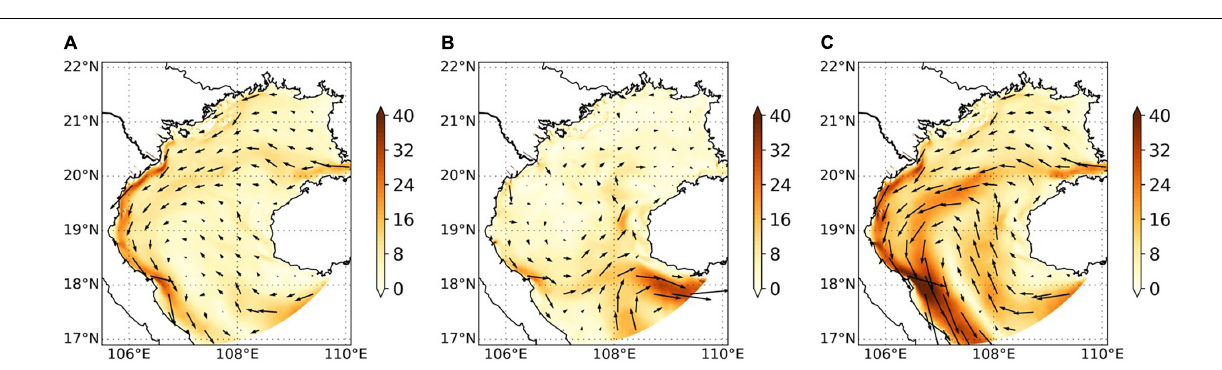
FIGURE 5 | Means of the detided daily surface current (cm/s) simulated by GOT_REF. (A) November – March average. (B) April – August average. (C) September – October